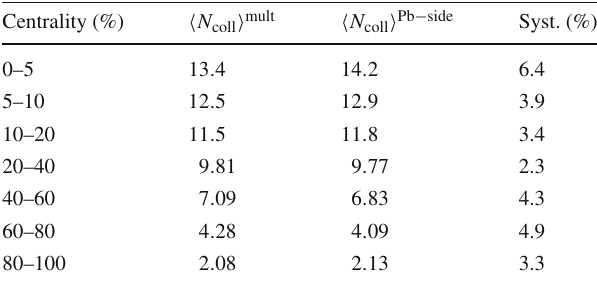
Table 2 Average number of hadronic nucleon collisions for the ZNA estimator, with the assumption of charged-particle multiplicity at mid- rapidity proportional to N part , (cid:3) N coll (cid:4) mult , and assuming the signal